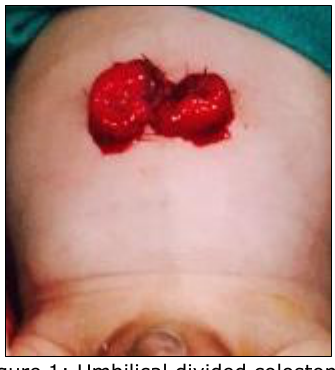
Figure 1: Umbilical divided